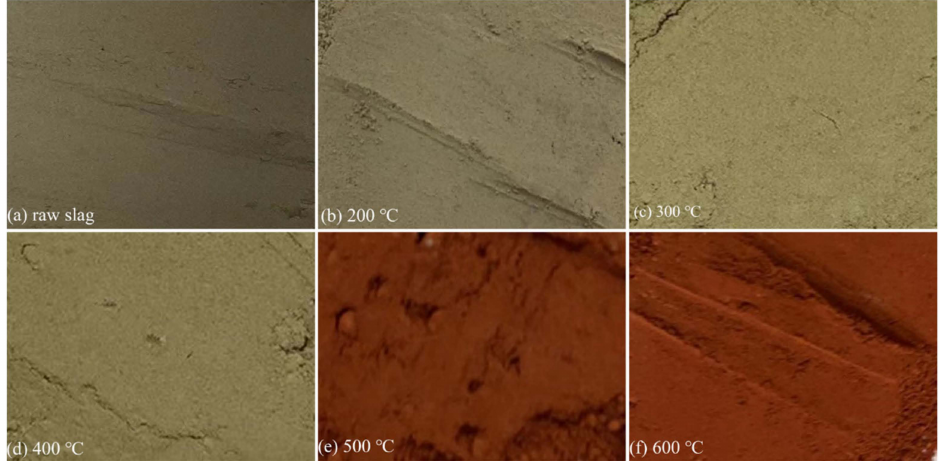
Figure 8. The images of ( a ) raw sample and roasted tantalum-niobium slag at ( b ) 200 ◦ C; ( c ) 300 ◦ C; ( d ) 400 ◦ C; ( e ) 500 ◦ C; ( f ) 600 ◦